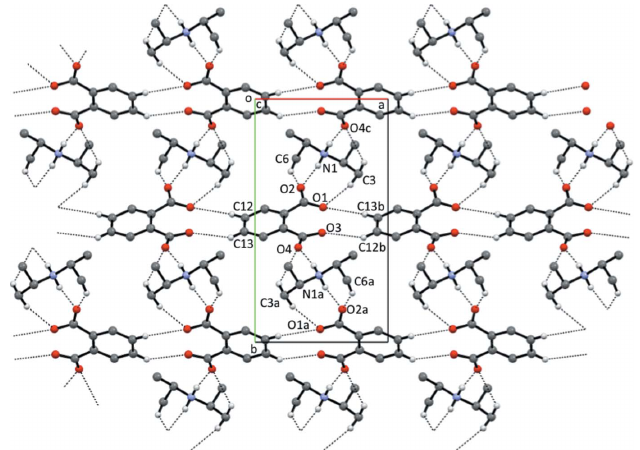
Figure 2 Partial packing diagram showing the hydrogen-bonding interactions. Only H atoms involved in the intermolecular interactions are shown. Symmetry identifiers: ( a ) (cid:3) x + 1, y + 1 y (cid:3) 1 , (cid:3) z + 1 . 2 2